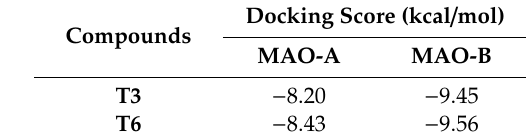
Table 3. Docking score values for T3 and T6 interactions with MAO-A or MAO-B. Compounds